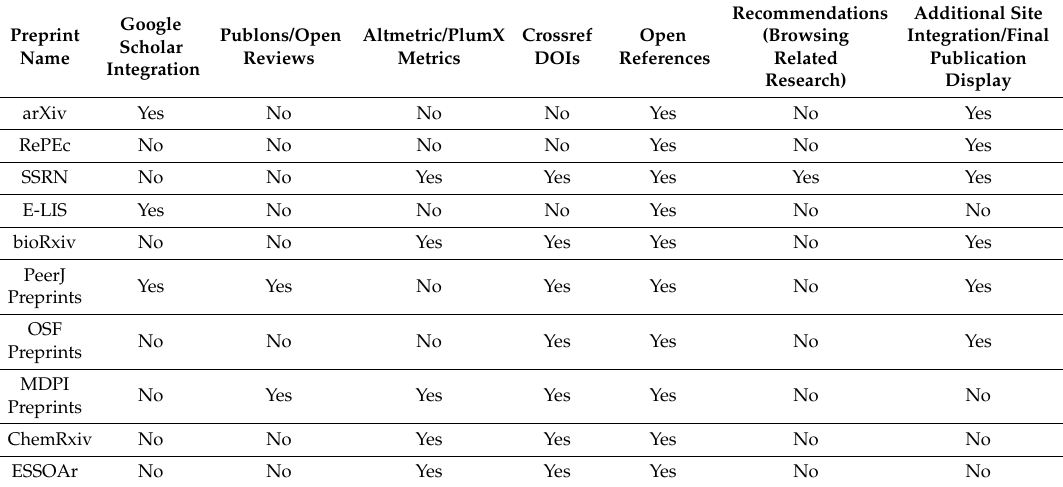
Table 4. Common features of open infrastructures and